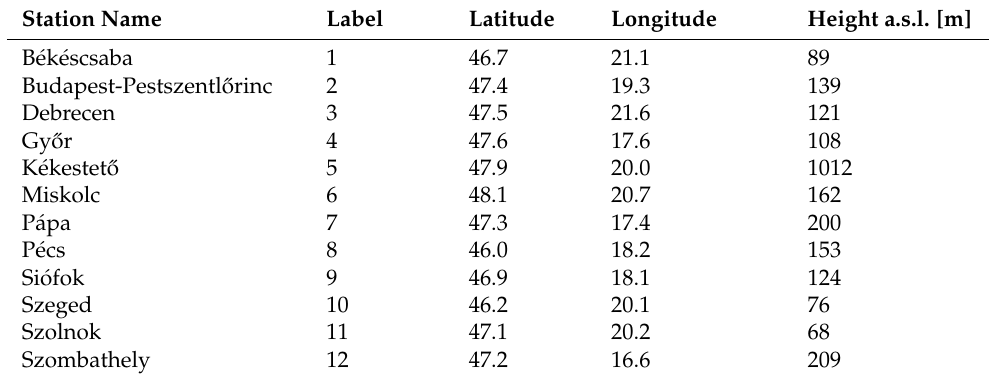
Table 1. Metadata of meteorological stations in Hungary. Height above the sea level (a.s.l) is displayed in